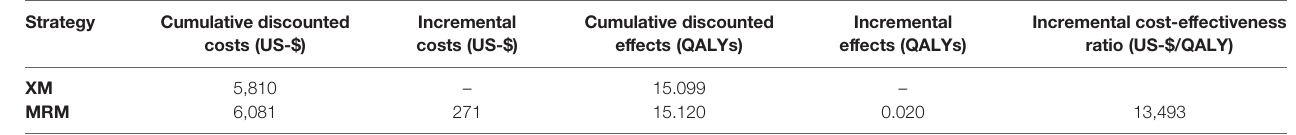
TABLE 2 | Cost-effectiveness analysis of the base-case scenario comparing MR-mammography (MRM) to x-ray mammography (XM).